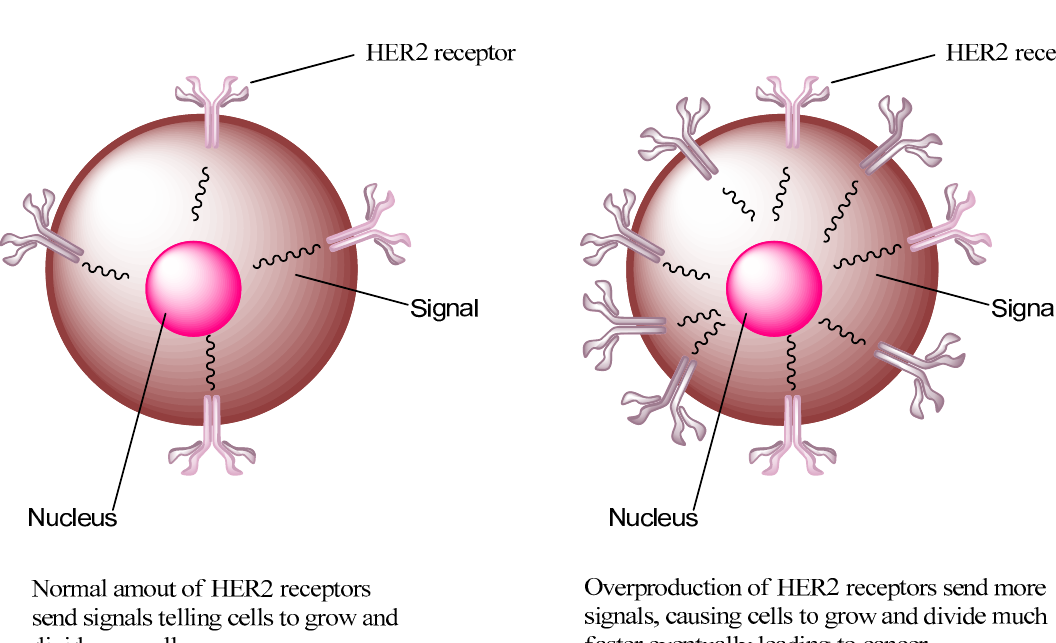
Figure 1. Normal HER2-positive breast cell and HER2-positive breast cancer cell.